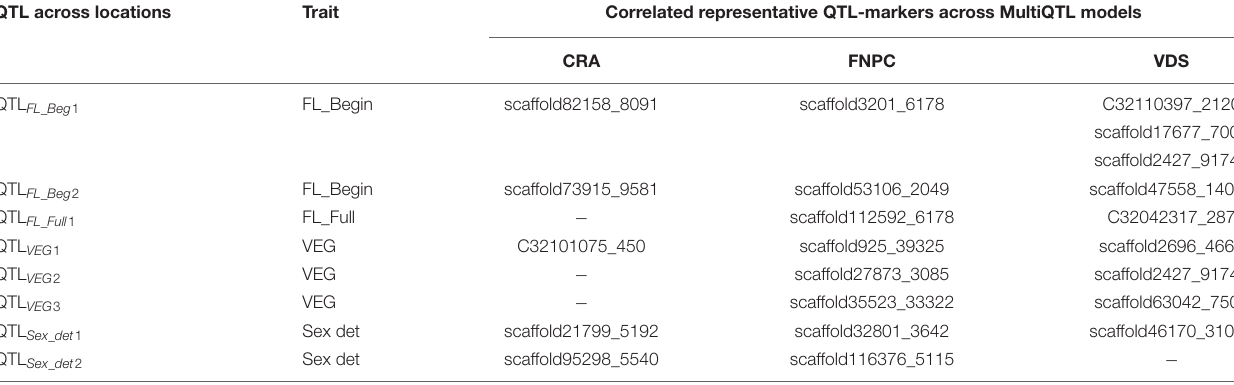
TABLE 3 | Identification of QTL regions across locations for flowering time traits and sex determination of hemp. QTL across locations Trait Correlated representative QTL-markers across MultiQTL